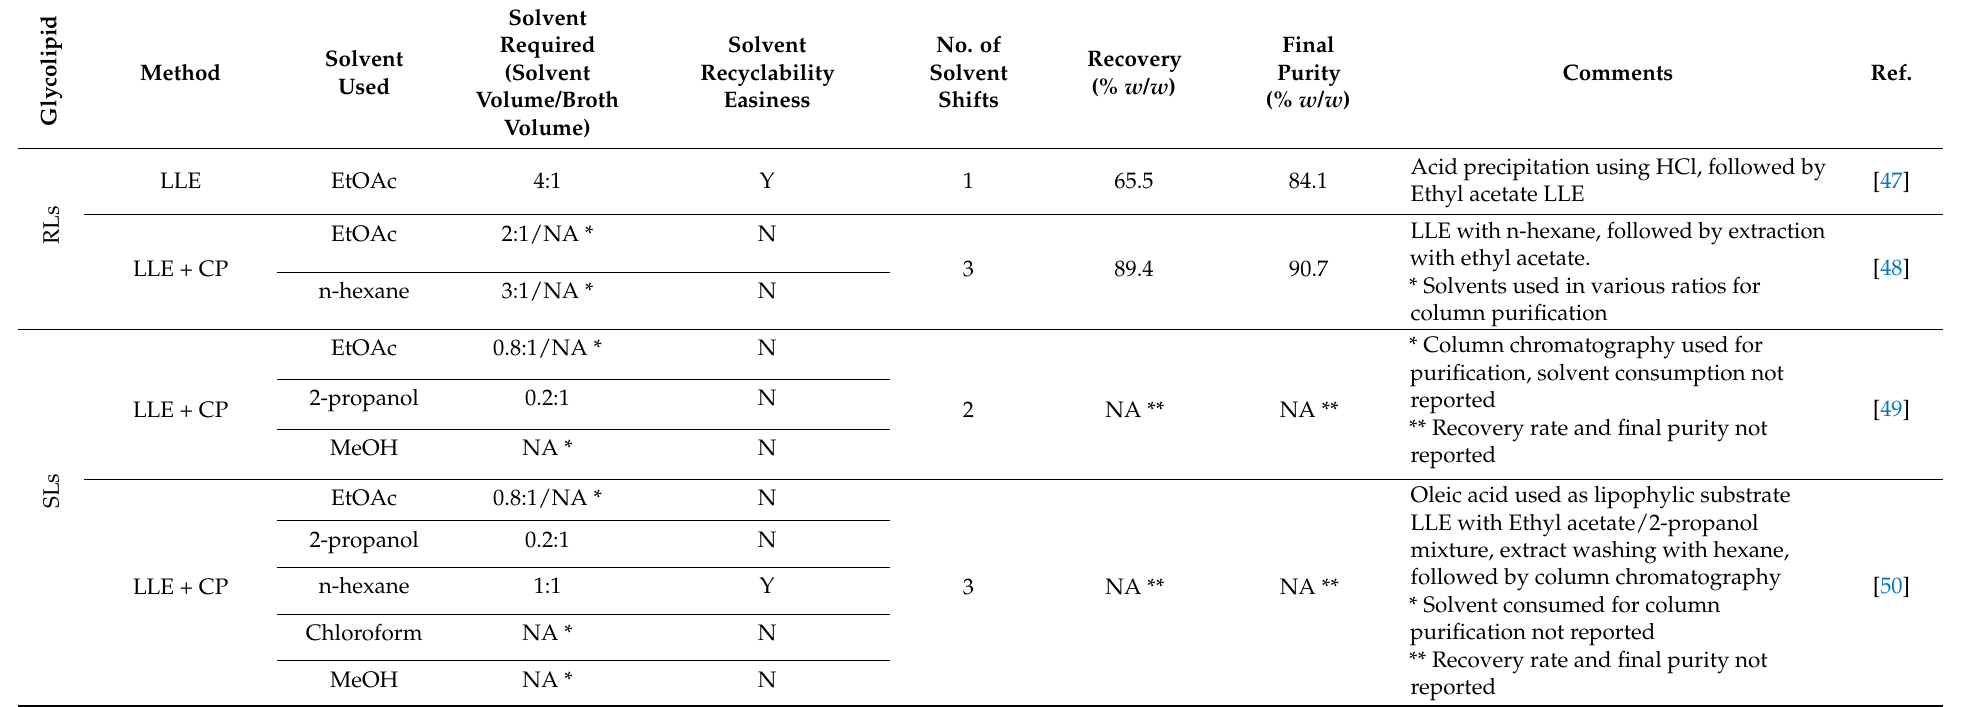
Table 7. The efficiency of downstream methods (LLE—liquid–liquid extraction; CR—crystallization, CP—column purification), indicating the solvent used, the amount of solvent required (volume of solvent/volume of fermentation broth), easiness to recycle solvent used (Y—for easy, N—for difficult), number of solvent shifts, percentage of recovery and final purity (%). A “/” is used to separate information from different unit operations within the same process. “NA” indicates omitted information in the source. At grey are the results obtained here in this